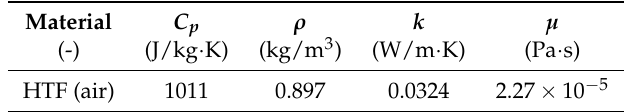
Table 1. Thermophysical properties of the heat transfer